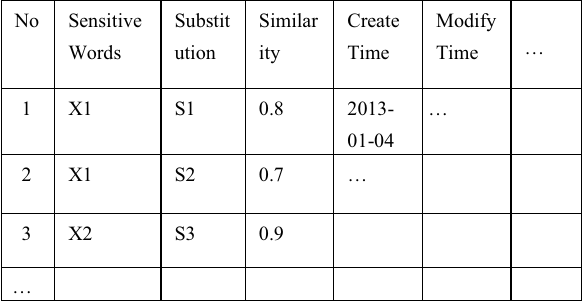
Table 1. The sensitive words and their